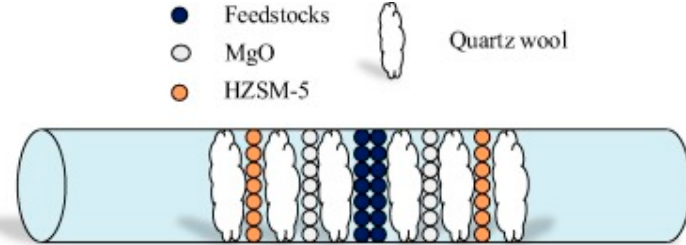
Figure 4. Schematic layout of feedstock and catalysts for the catalytic co-pyrolysis of bamboo residual and waste lubricating oil, reproduced with permission from [250]. Copyright Elsevier, 2018.